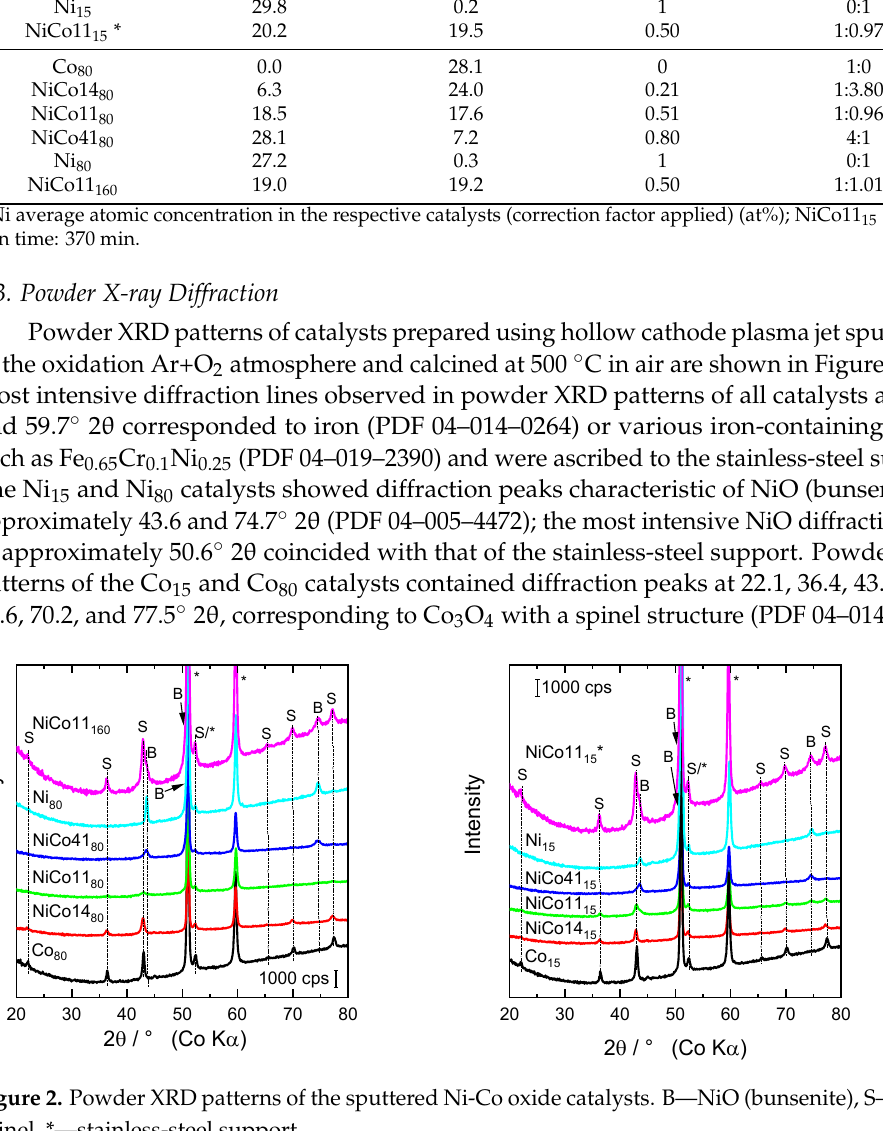
1:1.01 15 * deposi-